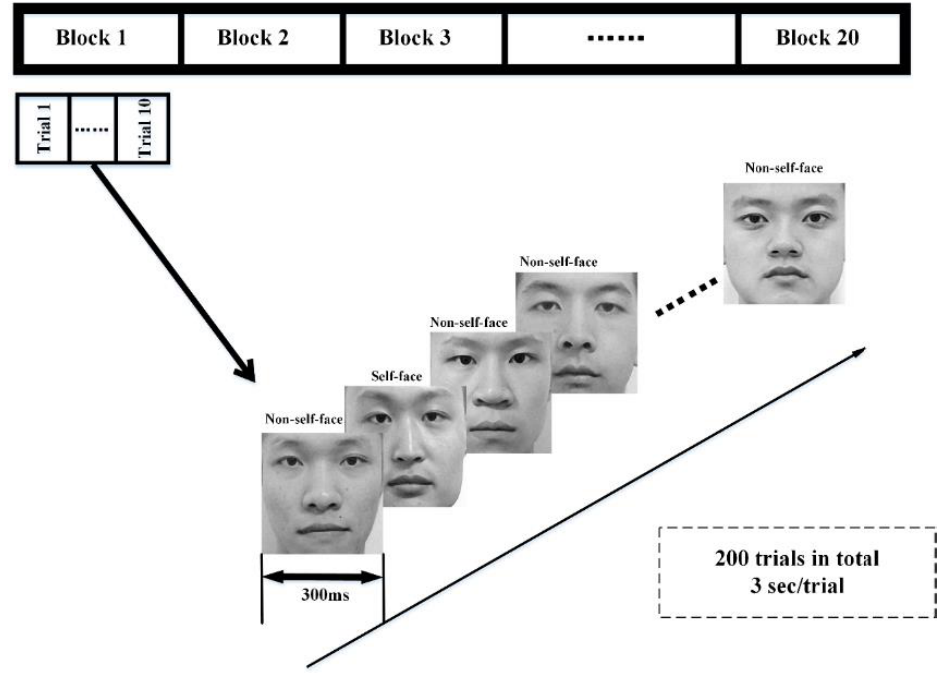
Figure 2. The self and non-self-face RSVP paradigm for identity authentication.